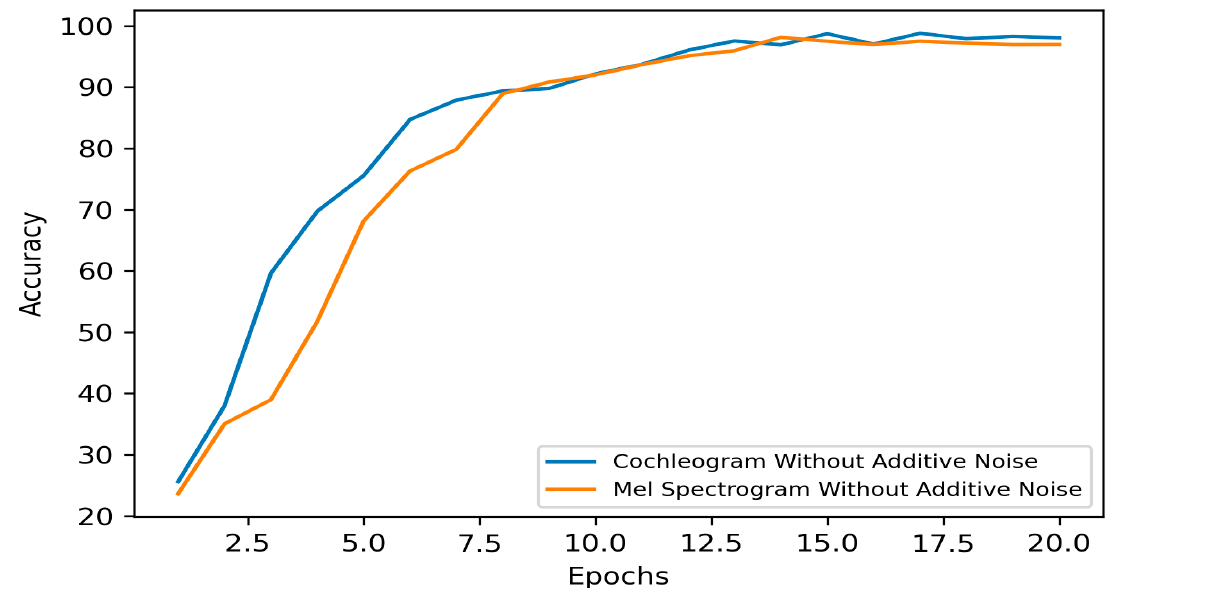
Figure 6. Speaker identification Accuracy of Cochleogram and Mel Spectrogram at Low Noise Ratio (Without Additive Noise) using VGG-16 Architecture.